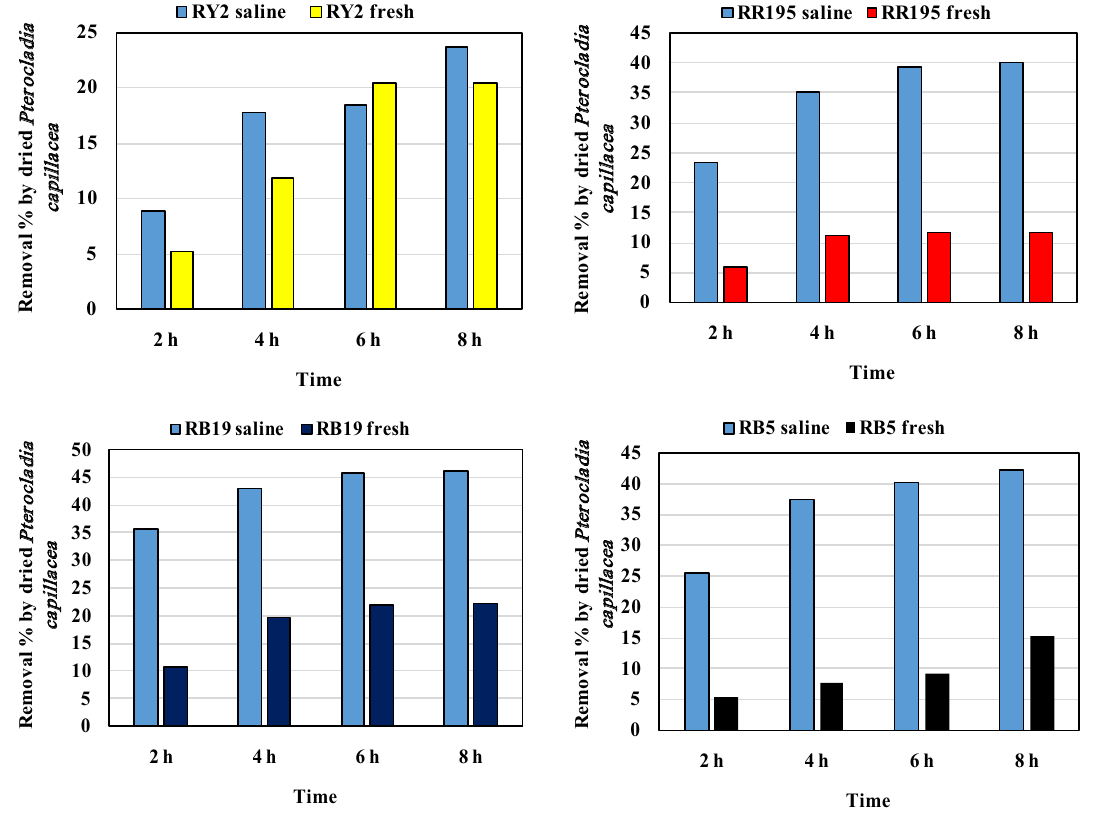
Fig. 12 Removal percentages of the four studied dyes by dried Pterocladia capillacea under saline and fresh conditions Table 13 Effect of contact time (at optimized conditions) on the removal percentages of the four studied dyes by fresh Ulva fasciata